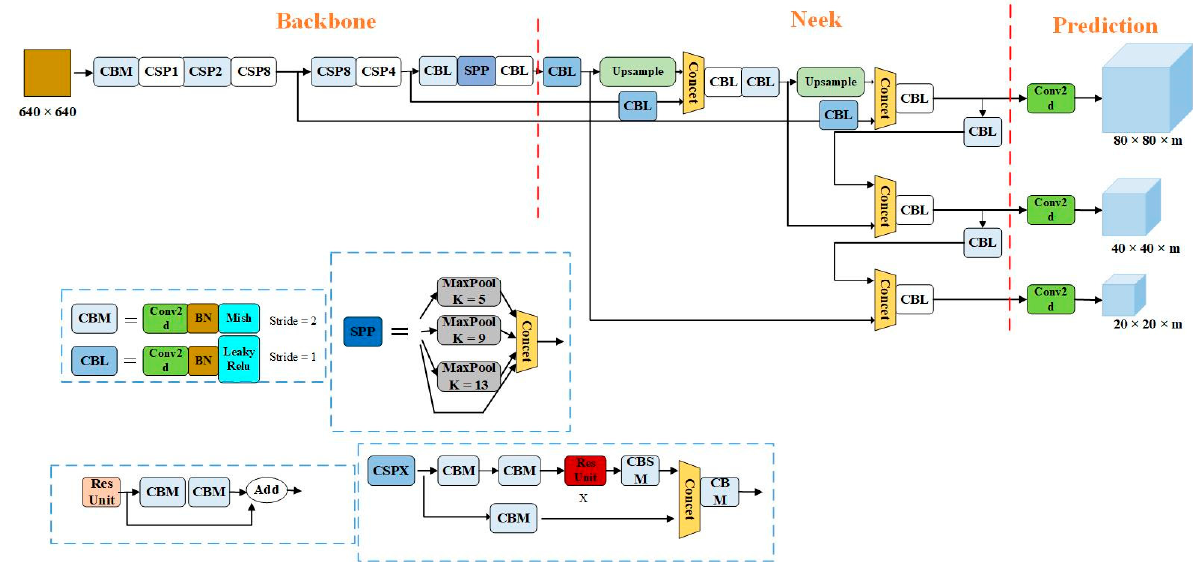
Figure 2. YOLOv4 network model.